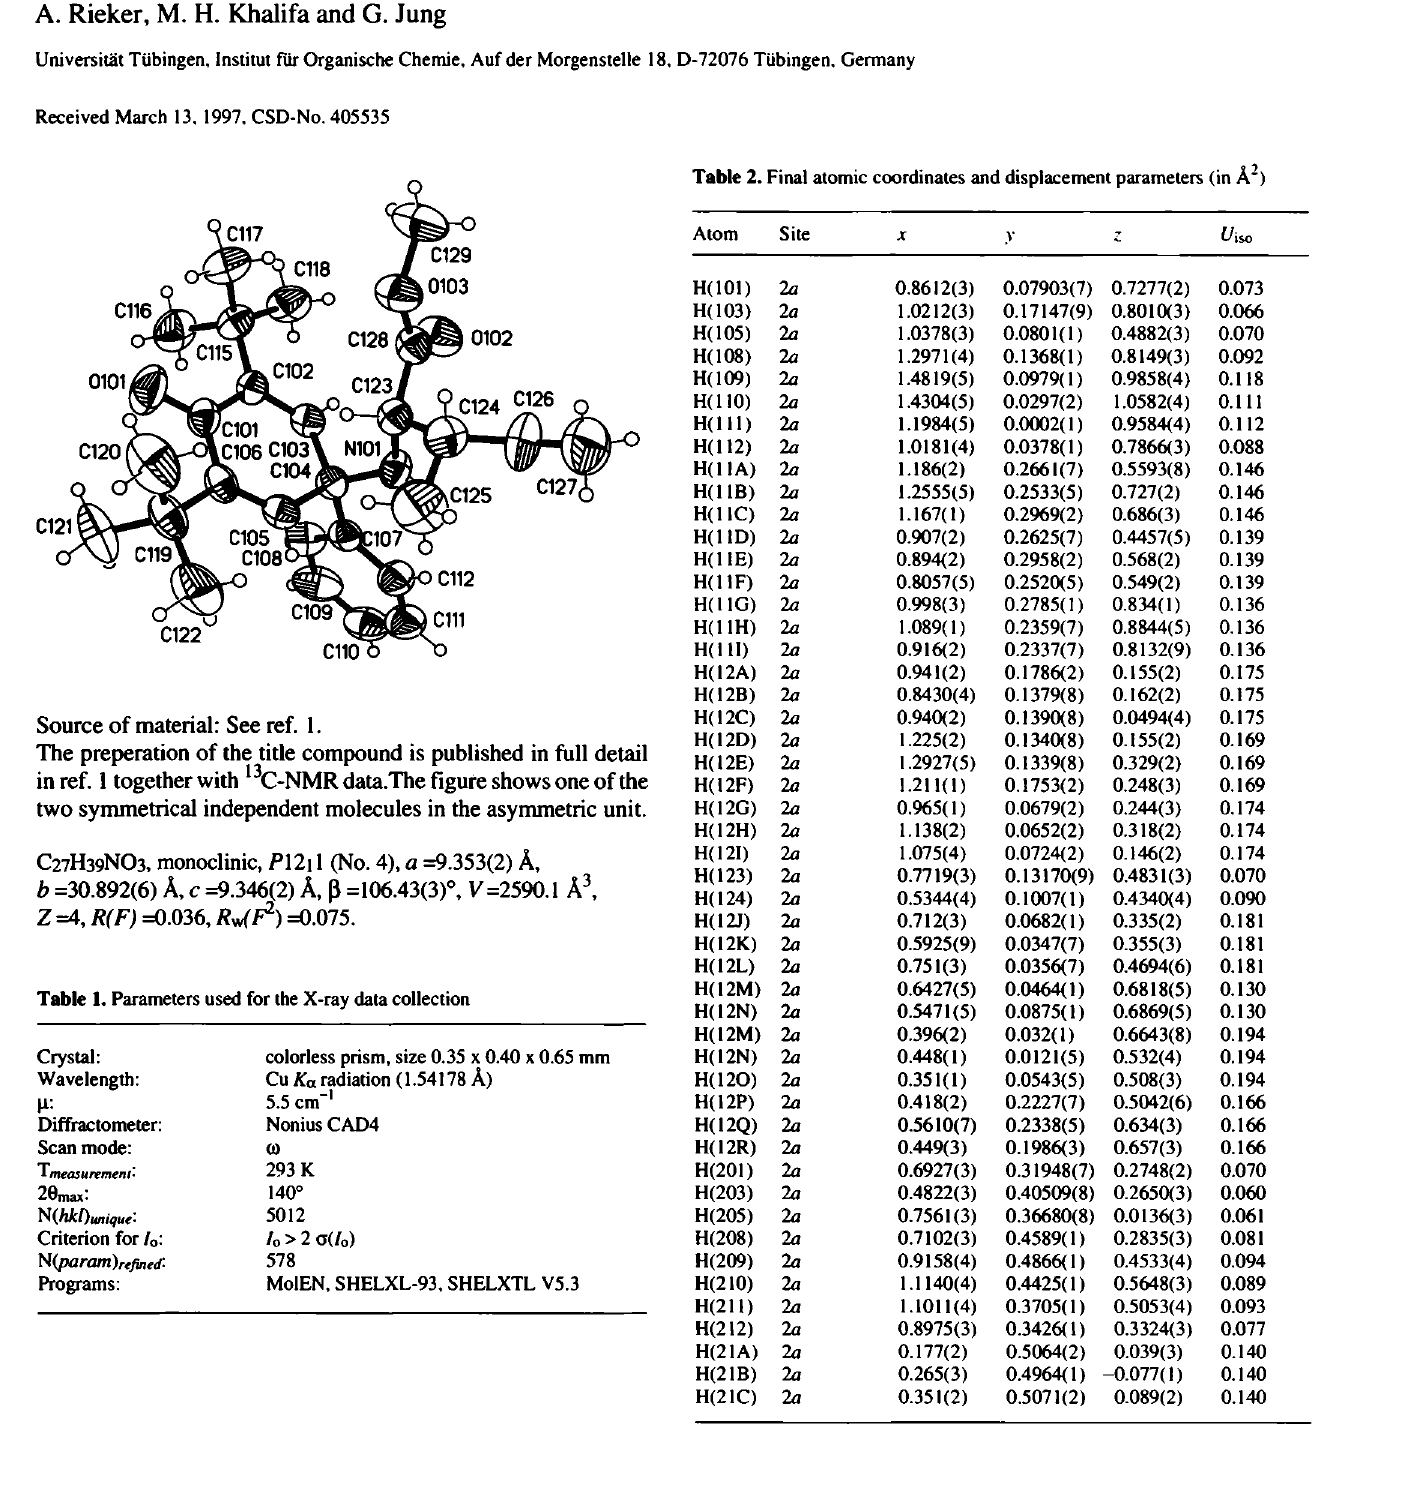
Table 1. Parameters used for the X-ray data collection